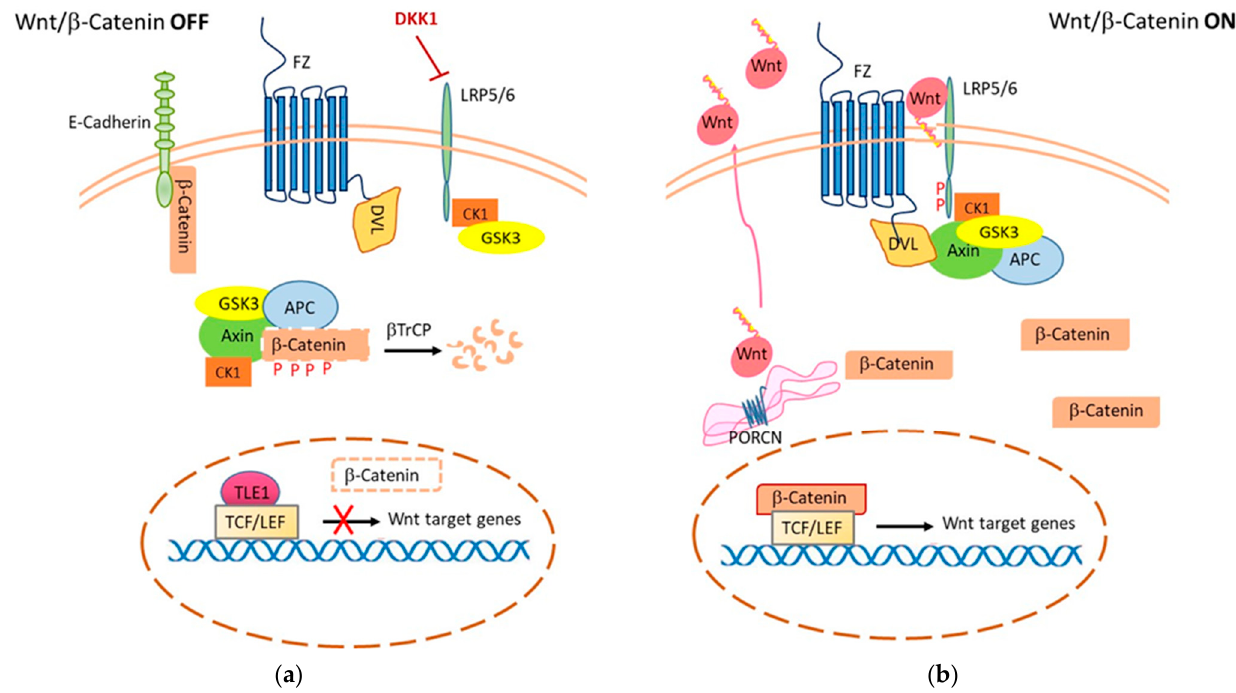
Figure 1. Wnt/ β -Catenin-dependent signaling. ( a ) In the OFF state, or absence of Wnt ligand, cyto- plasmic β -catenin undergoes phosphorylation by the destruction complex (composed of Axin, APC, CK-1, and GSK-3). This leads to degradation of β -catenin in the proteosome after being ubiquitinated by β -TrCP. In the nucleus, transcription of target genes is repressed through the TLE-1 complex with TCF/LEF. ( b ) In the ON state, porcine acylase (PORCN) o-acylates Wnt ligands and facilitates their secretion and interaction with receptors. Binding of Wnt to the Frizzled receptor causes phosphorylation of the LRP co-receptor by CK1 and GSK3. Dvl protein is recruited to the plasma membrane and blocks the β -catenin destruction complex. This causes β -catenin to accumulate in the cytoplasm and then translocate to the nucleus, where it forms a complex with TCF/LEF to transcribe its target genes (i.e., cyclin D1, c-Myc, vascular endothelial growth factor (VEGF), interleukin-8 (IL- 8), etc.).